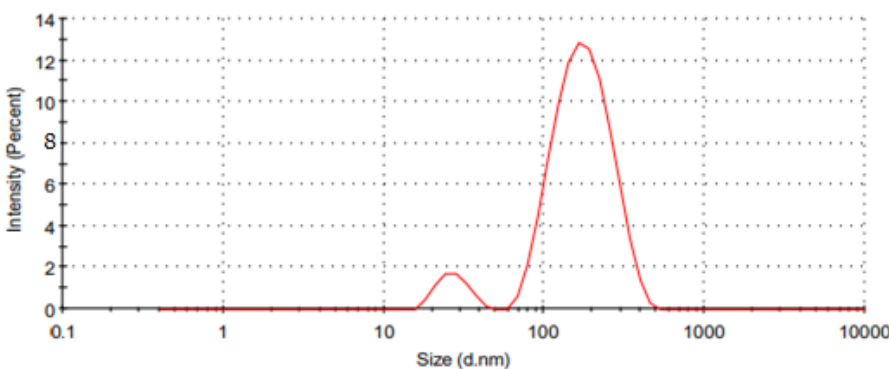
Figure 6. Graph of average particle size distribution of the optimized (F5) essential-oil-loaded nanoemulsion.